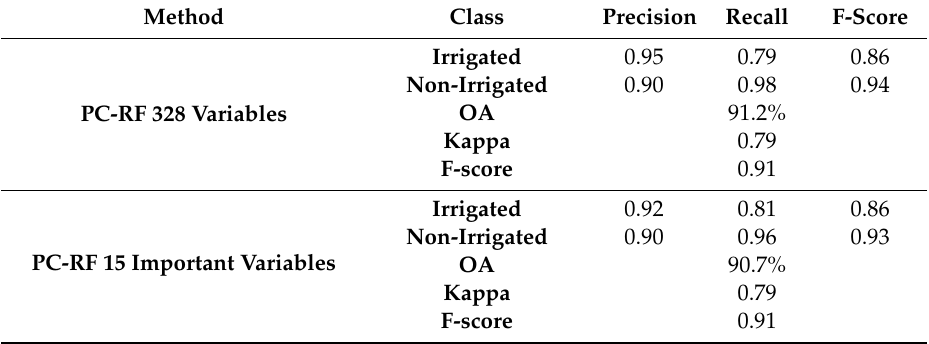
Table 3. The values of the overall accuracy, Kappa, F-score, precision, and recall obtained from the RF classifier using the 328 SAR PC variables and 15 important SAR PC variables.